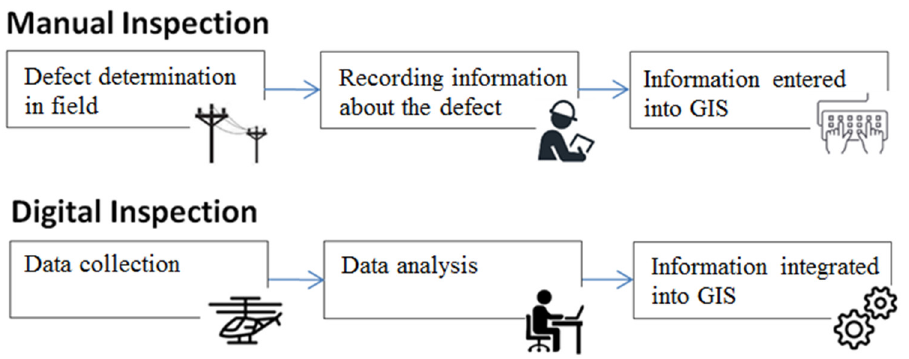
Figure 5. Process flows of manual and digital inspection.